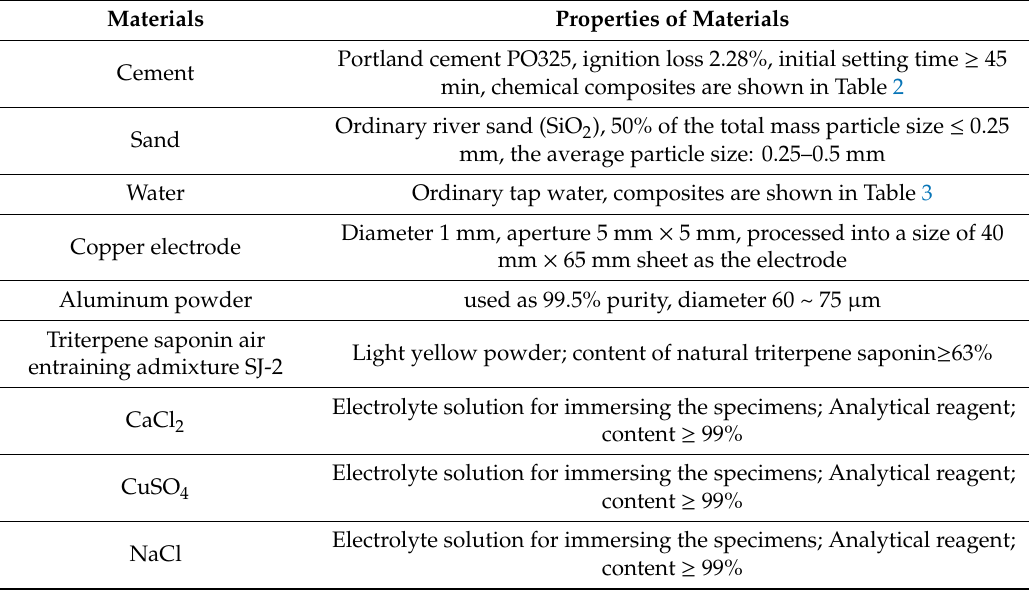
Table 1. Material properties.